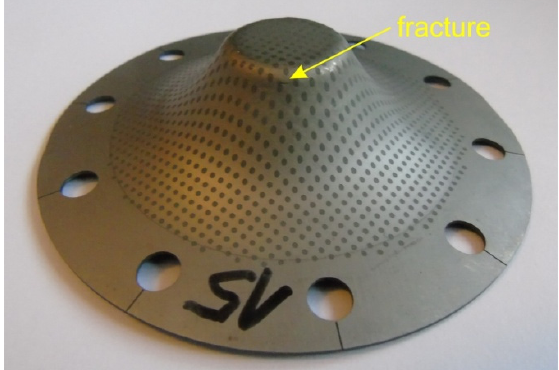
Figure 7. Fractured VWACF produced in run 15.